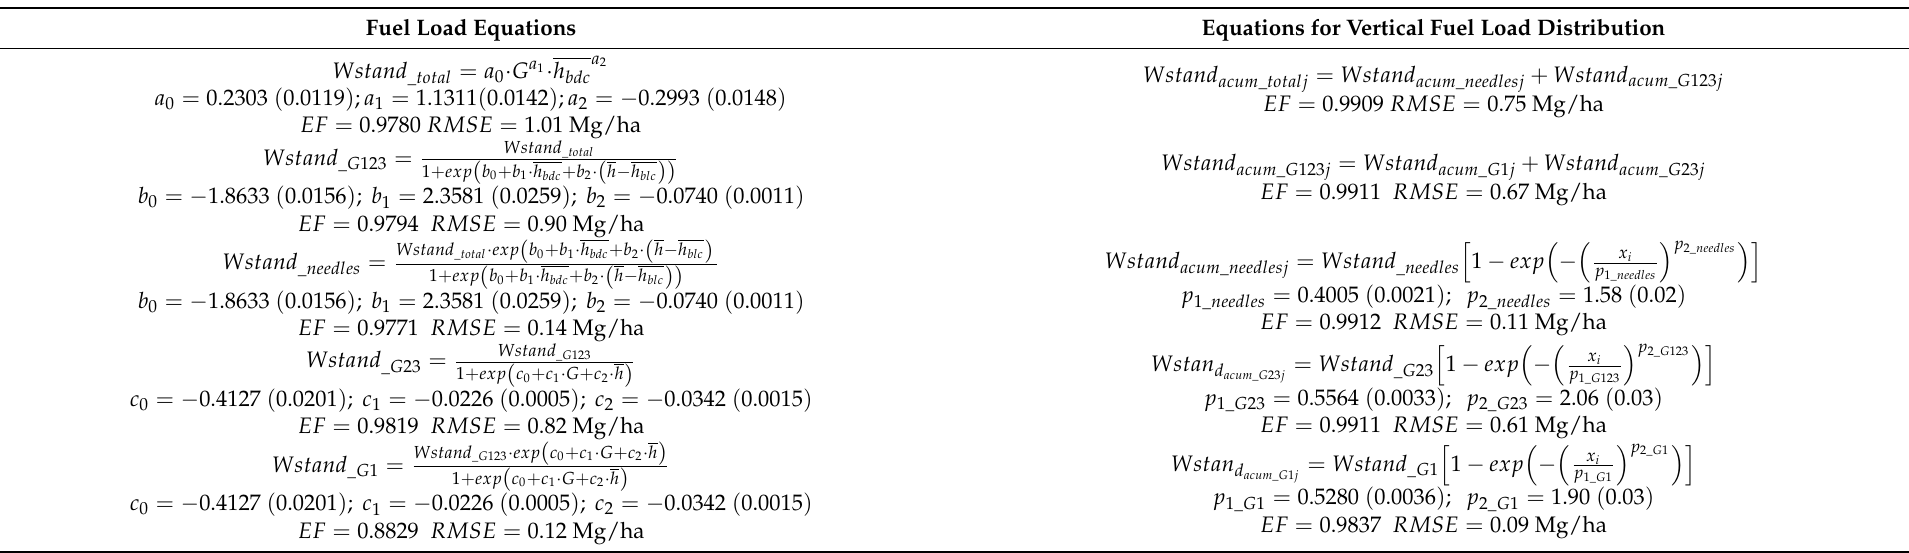
Table 4. System of 8 equations fitted simultaneously to estimate dead fuel loads and their vertical distribution according to fuel fraction at stand level. Fuel Load Equations Equations for Vertical Fuel Load